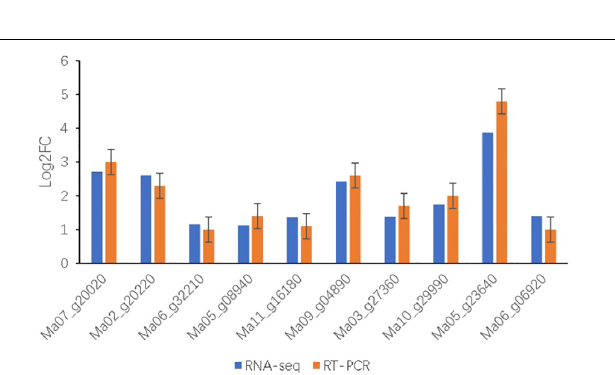
FIGURE 7 | Relative expression levels of 10 genes after salt treatments in BD banana were examined by qRT-PCR. The relative gene expression levels were determined by 2 − (cid:49)(cid:49) CT . Transcript levels were normalized to the expression level of UBC. Data are means ± SD of n = 3 independent